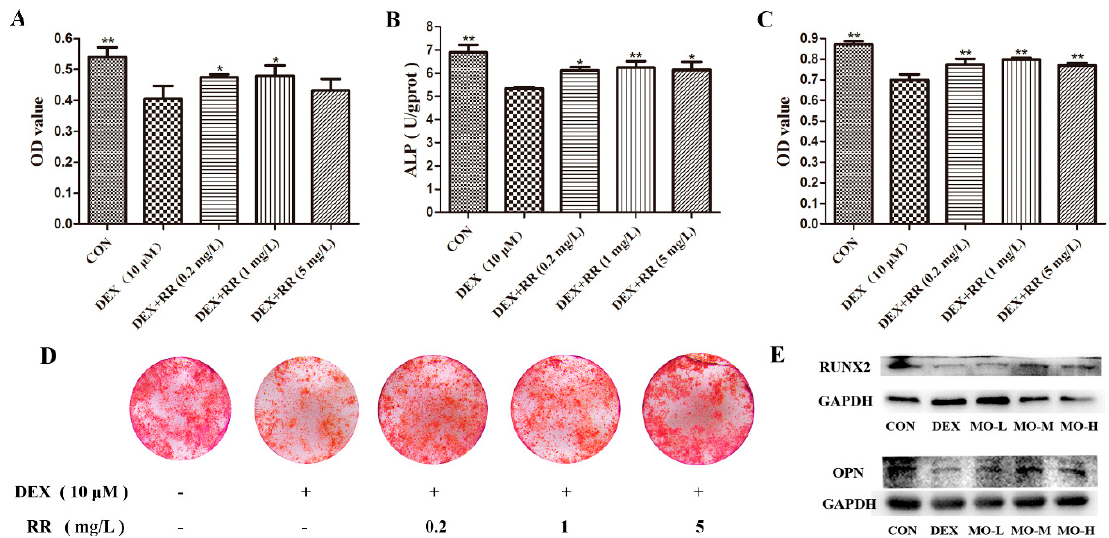
Figure 4. Effects of RR on the proliferation, differentiation, and mineralization levels of DEX-injured osteoblasts. ( A ) MTT assay; ( B ) ALP activity; ( C ) extracellular matrix mineralization; ( D ) representative images of osteoblastic bone mineralization nodule stained with alizarin red; ( E ) the protein expressions of RUNX2 and OPN. Values were expressed as the mean ± SD; ( A ) n = 4, ( B – F ) n = 3. * p < 0.05, ** p < 0.01 compared with DEX